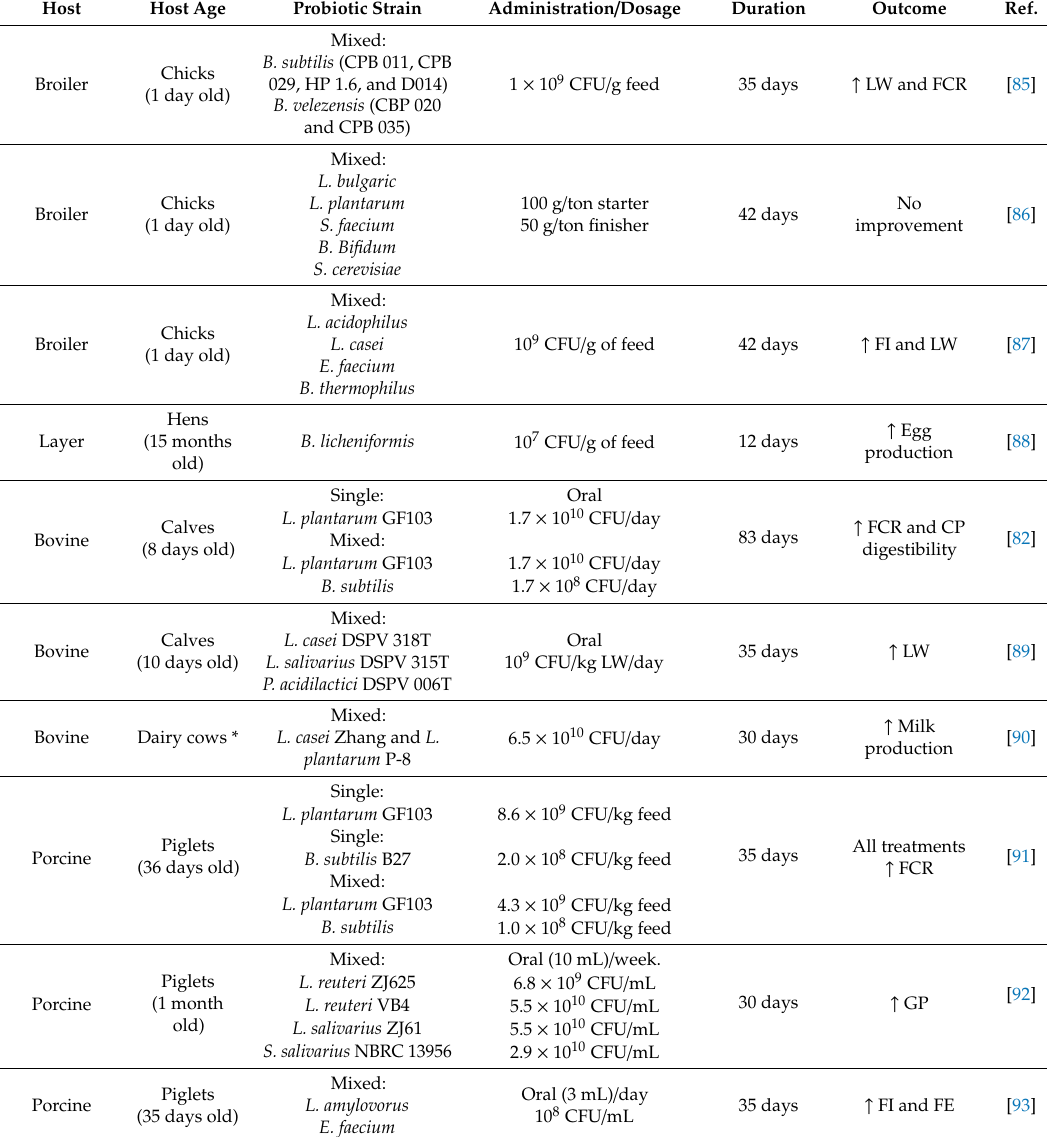
Table 1. E ff ects of probiotics on growth and performance of farm